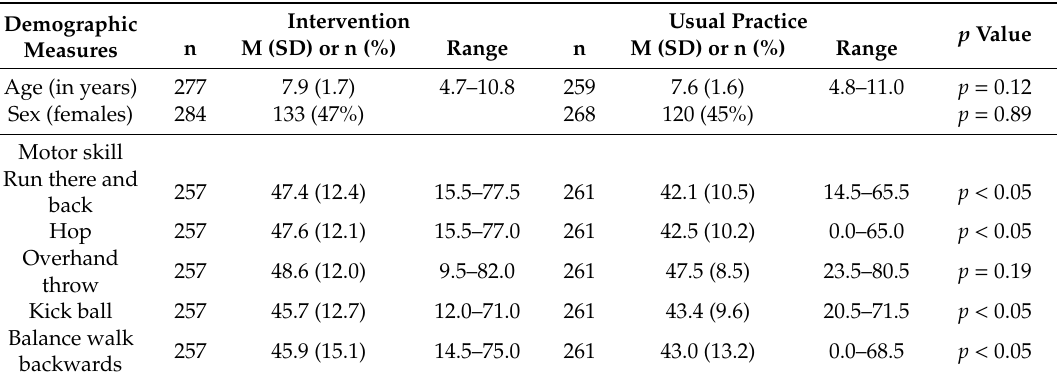
Table 7. Baseline demographics and motor skills di ff erences between